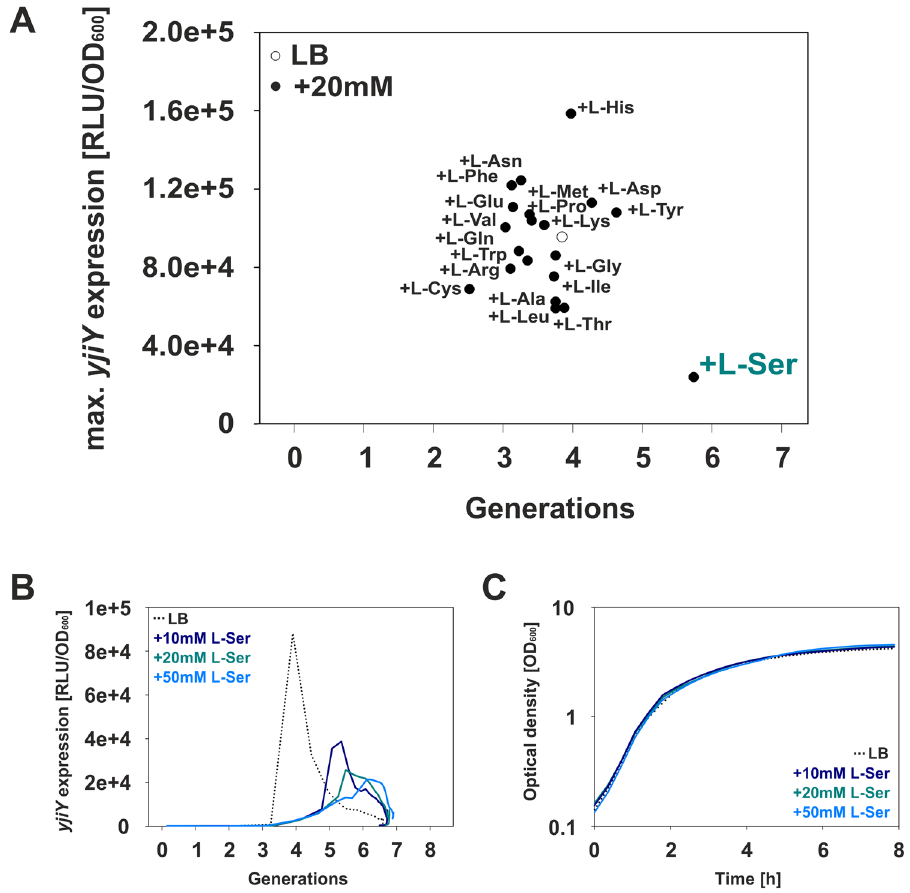
Figure 2. Effects of an excess of individual amino acids on the expression of yjiY . ( A ) E . coli MG1655/pBBR yjiY - lux was grown in LB medium supplemented with one of the indicated amino acids (at 20 mM), and growth and luminescence were monitored over time. Maximal yjiY expression values are depicted. The open circle provides a benchmark and indicates yjiY expression in E . coli grown in LB medium. ( B ) Expression of yjiY in LB (dotted line) supplemented with increasing L-serine concentrations. ( C ) Corresponding E . coli growth curves in LB media supplemented with increasing L-serine concentrations. Experiments were performed at least three times (standard deviation < 10%), and results of a representative experiment are